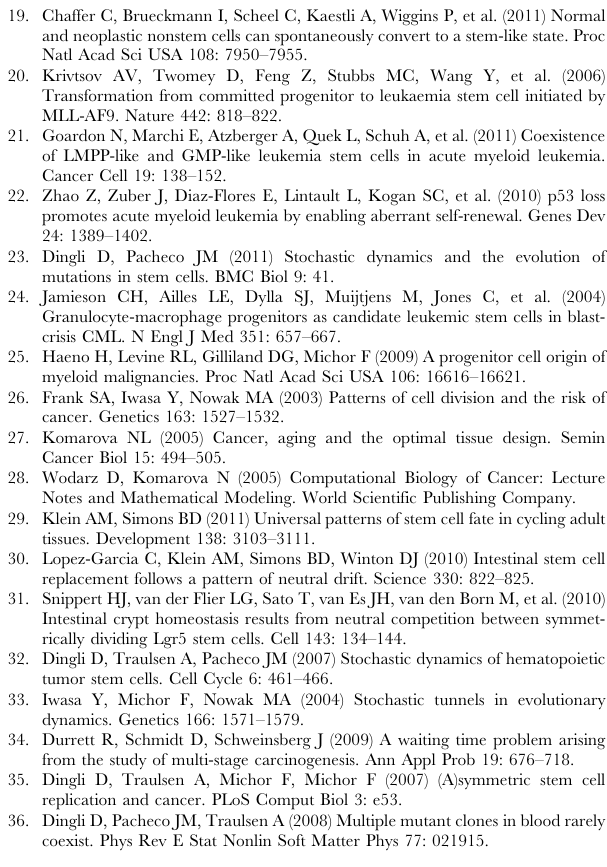
Figure S4 Comparison of two Model I variants with all- mutant progenitor dedifferentiation and two-mutant progenitor dedifferentiation. (A) Fixation time distributions in constant stem cell population size model for potential dedifferentiation of only two-mutation progenitors (red, Eq. (8)) and potential dedifferentiation of all progenitor cells (blue, Eq. (S9)). (B) Fixation time distributions in constant stem cell population size model with dedifferentiation of all progenitor cells. Blue: all progenitor cells equally likely to dedifferentiate with dedifferentiation probabilities given by Eq. (S9). Red: all progenitor cells can dedifferentiate with dedifferentiation proba- bility weighed by birth rate given by Eq. (S10). Progenitor dynamics without competition (Eq. (2)). Green: all progenitor cells